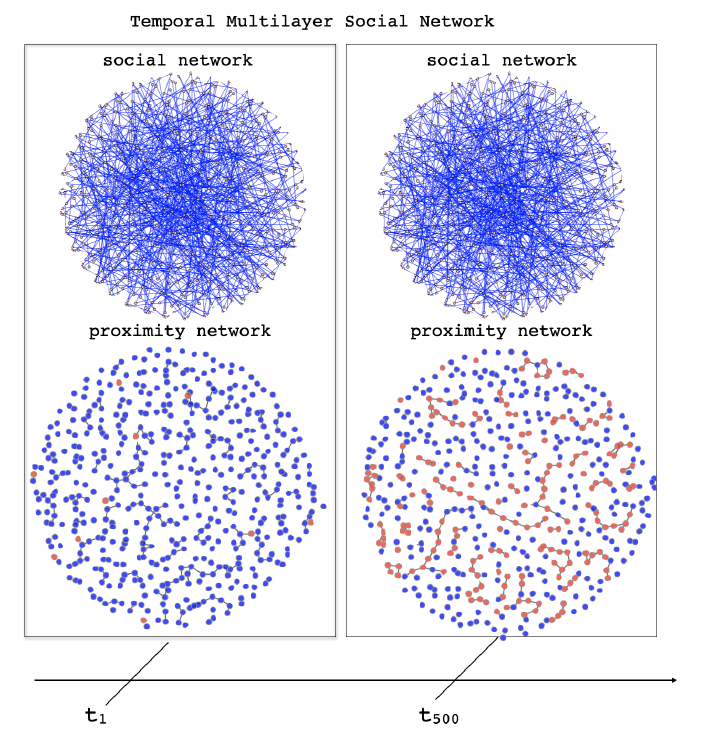
Figure 2. Spreading dynamics of user experience in the temporal multilayer social network. The plot displays the spreading of user experience within the network M , showing the time steps t 1 , t 500 selected in T . The network M is composed of a virtual social network layer (the two graphs in the upper portion) and a proximity network layer (the two graphs on the lower side). The red circles represent the infected nodes, the blue circles the susceptible nodes.